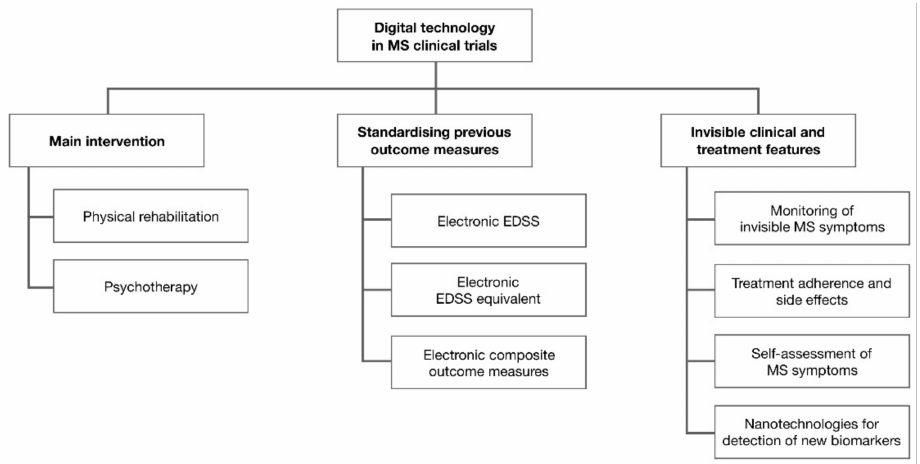
Figure 2. Digital technology in clinical trials for multiple